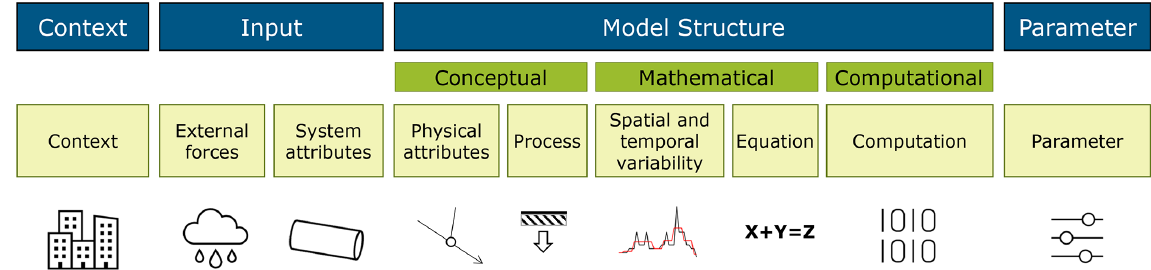
Figure 2. Classification of the location of uncertainties in models, based on Walker et al. (2003) and Gupta et al. (2012). Adapted graphically from Pedersen et al.